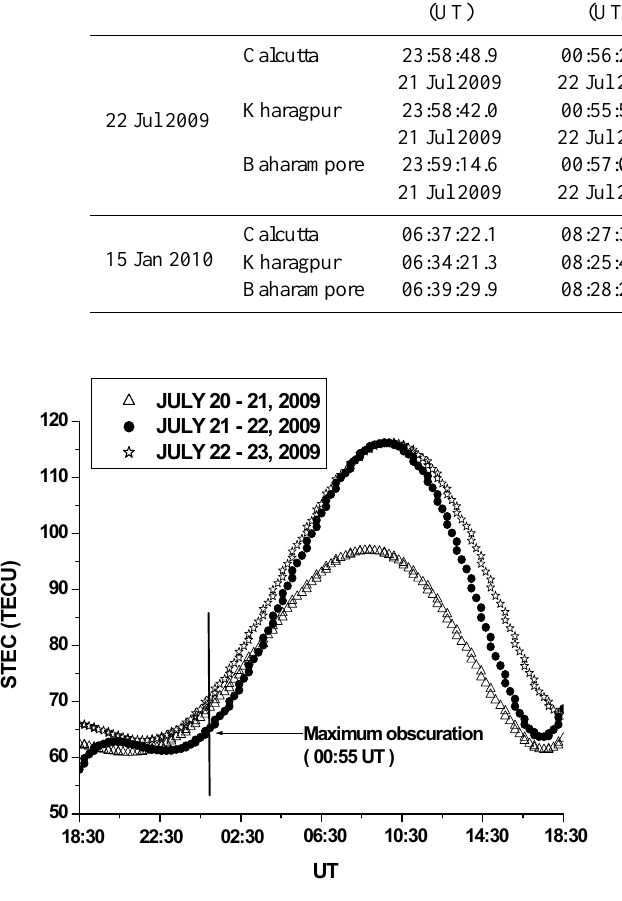
Fig. 3. Best-fit polynomial curves for the three days, namely,